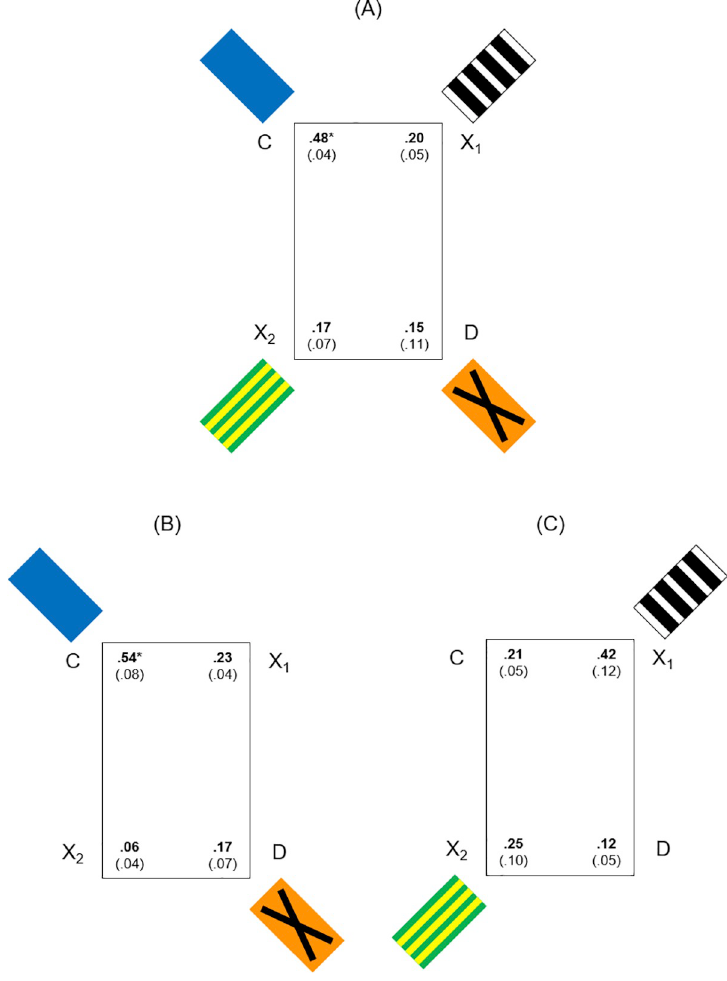
Fig 4. First approaches in Experiment 1: Rectangular apparatus with panels in the spontaneous memory task. (A): Mean (SD) proportions of first approaches at the four corners, in the spontaneous memory task, in the experimental condition with four colored panels at corners in the rectangular apparatus (geometry + landmarks) ( Experiment 1 ). (B) and (C): Mean (SD) proportions of first approaches in the experimental conditions with two colored panels at corners C-D (landmark near the correct corner) and X1-X2 (landmark far from the correct corner) in the rectangular apparatus. The asterisk ( � ) indicates a statistically significant difference (p < 0.05).